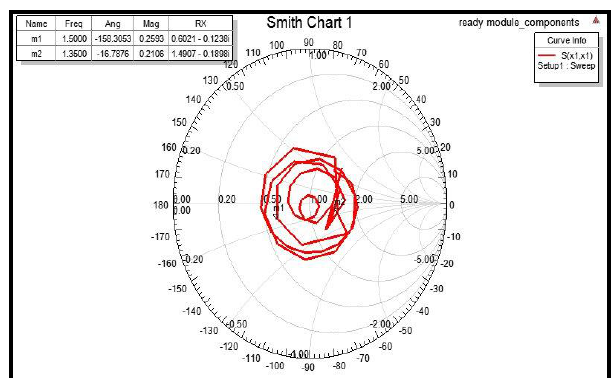
Figure 8: Polar radiation pattern of antenna at